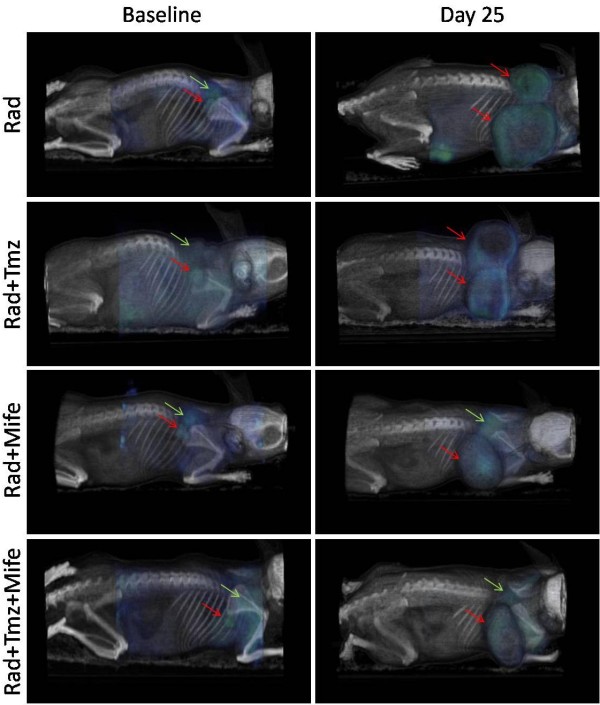
PET/CT images showing 18F-FDG tumor uptake. The groups are: Rad, Rad + Tmz, Rad + Mife and Rad + Tmz + Mife. Left images represent the beginning of treatment (baseline) and right images the end of the study (day 25). Red arrows indicate tumor location at baseline and day 25; green arrows show sites of typical 18F-FDG uptake in brown adipose tissue (BAT).